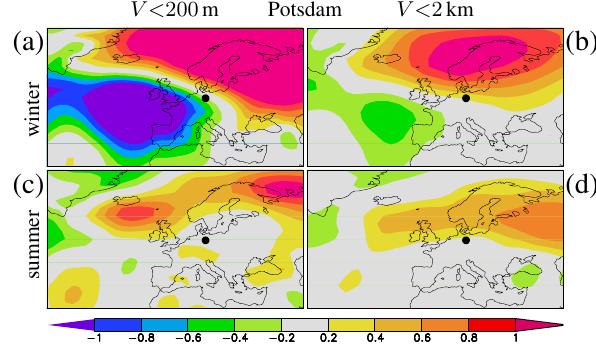
(rotated) EOFs of the large-scale flow, such as the North- Atlantic Oscillation. The regressions of Figs. 8–10 usually consist of a dipole around the point at which the fog is ob- served. This suggests the use of local geostrophic wind at the surface (the first derivatives of the SLP field) and vorticity